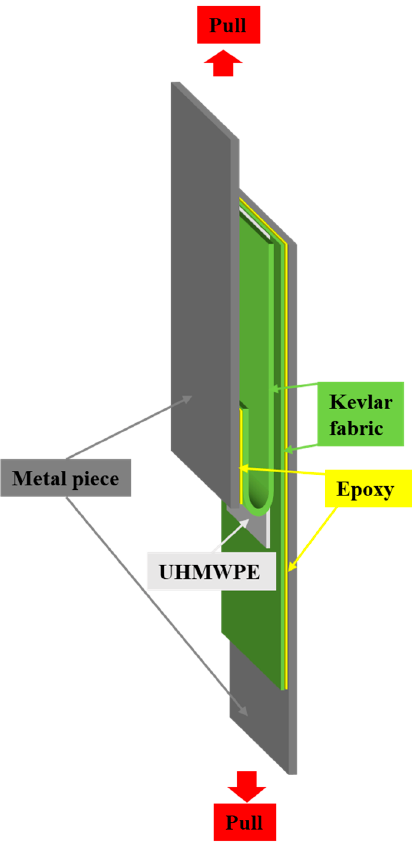
Scheme 1. Schematic showing sample configuration for peeling test.